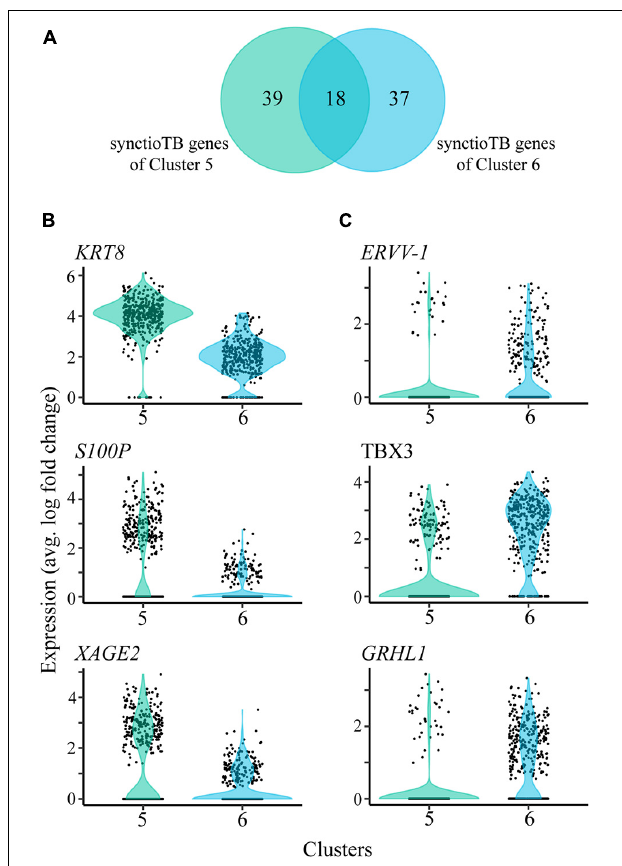
FIGURE 4 | SyncytioTB-specific gene expression profiles. (A) Comparison of the SyncytioTB specific genes in clusters 5 and 6. The two clusters have many differentially expressed genes, with some that are more highly expressed in cluster 5 (B) and others that are more highly expressed in cluster 6